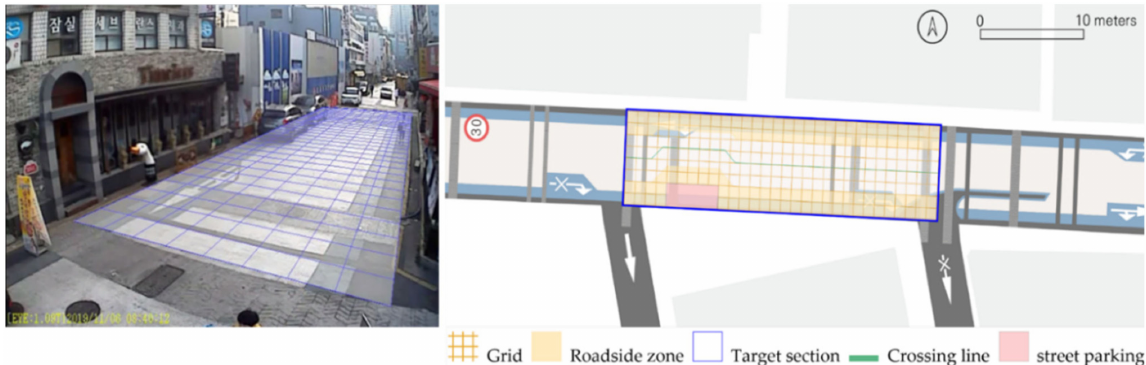
Figure 3. Example of grid projection and defining roadside zone and centerline (Baekjegobun-ro